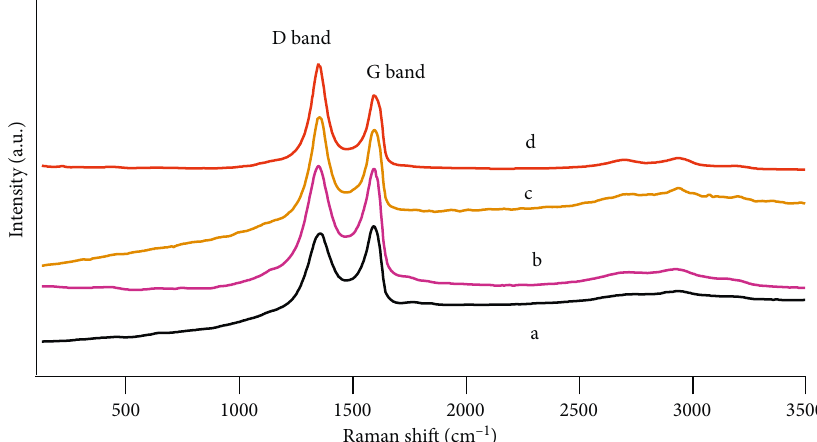
Figure 4: Raman spectra of (a) GO, (b) PASG.N, (c) PASGN.N, and (d)